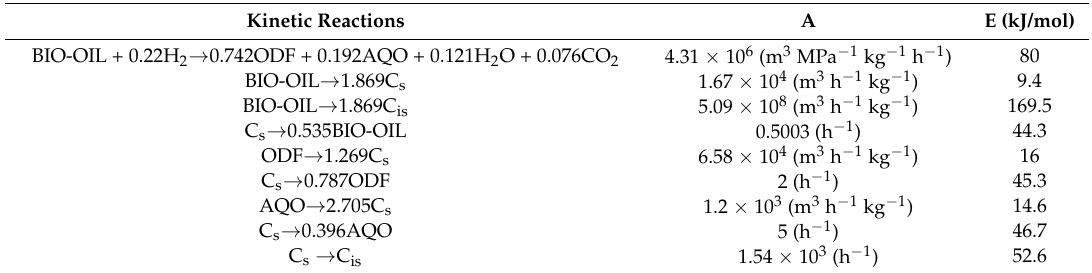
Table 2. Kinetic parameters of bio-oil hydrogenation in the mild hydrogenation